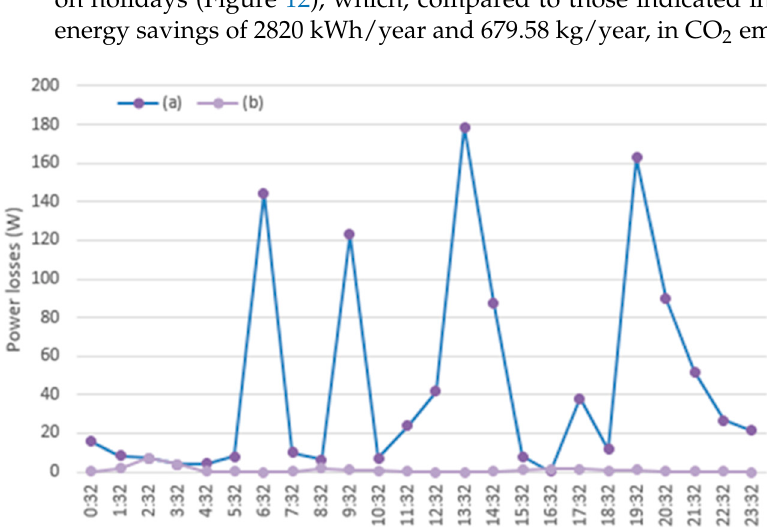
Figure 12. Transformer power losses due to reactive currents ( P (cid:48) cr ) after applying actions for optimiz- ing the operation of the capacitor bank Q c 2 : (a) working days, and (b) holidays.